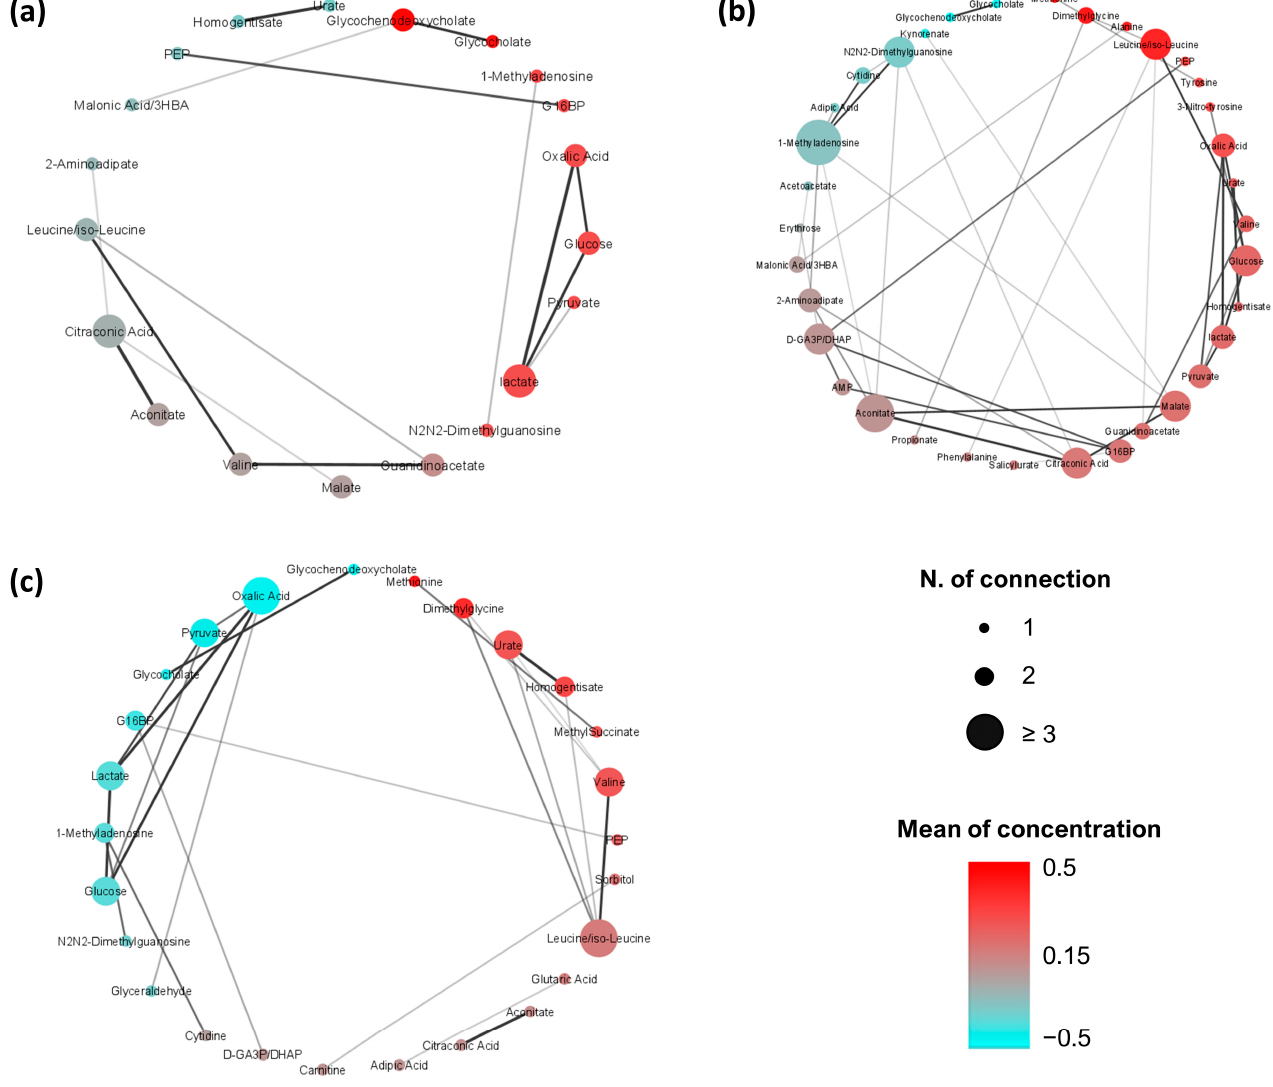
Figure 2. Metabolite-metabolite association network of ( a ) CRC patients; ( b ) PP patients; ( c ) CTR. Only the significantly (Benjamini-Hochberg adjusted p -value ≤ 0.05) different connections among metabolites are reported. Nodes are colored according to their mean of concentration (from light blue to red) and their dimension is proportional to the increasing metabolite-metabolite degree of connectivity. Edges represent correlation with | r | ≥ 0.6 and their transparency depends on the likelihood of the metabolic connections.